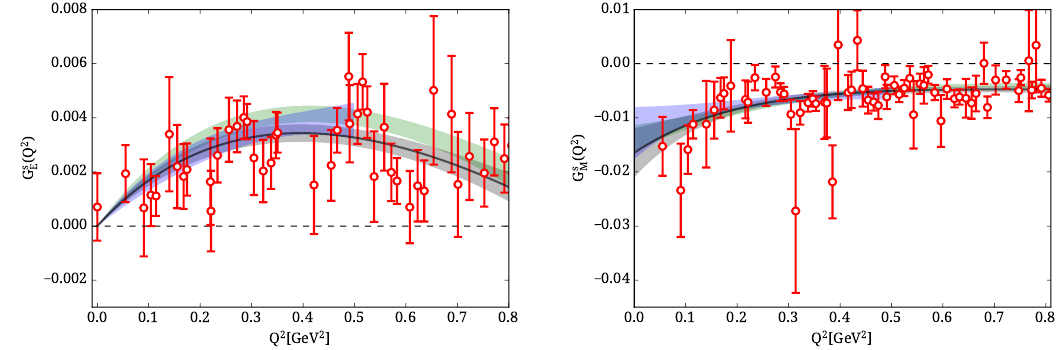
Figure 12: Strange electric (left) and magnetic (right) form factors as a function of Q 2 . The different coloured band show systematics due to using different fit range and the plateau versus the summation determination [ 24 ]